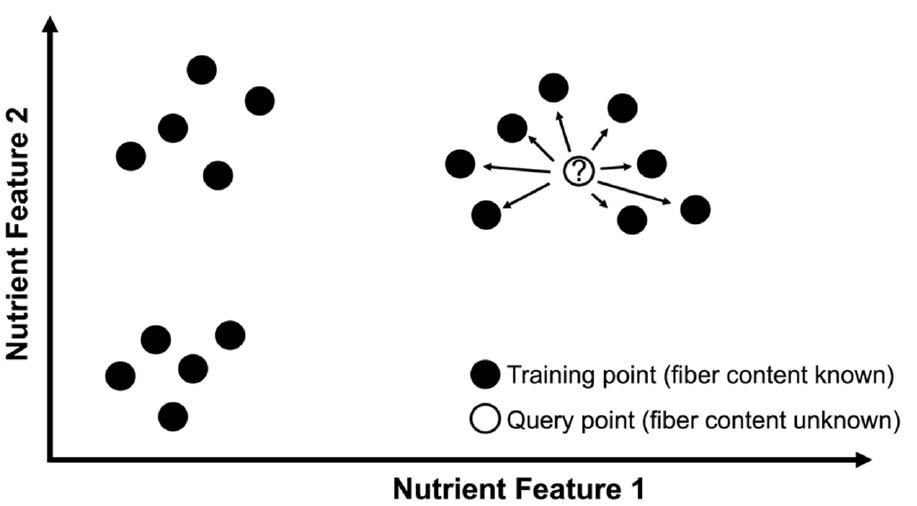
Figure 2. Visual presentation of k-nearest neighbors (KNN) algorithm for fiber content prediction. A query product’s fiber content is predicted by considering the eight neighboring products’ fiber values in feature space. Demonstration is in 2D feature space for easier visualization, e.g., nutrient feature 1 could be normalized total sugar content per 100 g or 100 mL and nutrient feature 2 could be normalized starch content per 100 g or 100 mL. For the implemented algorithm, the feature space is composed of six normalized nutrient features: total sugar, starch, protein, saturated fat, unsaturated fat, and sodium. Nearest neighbors are always selected from the same food category as the query product.